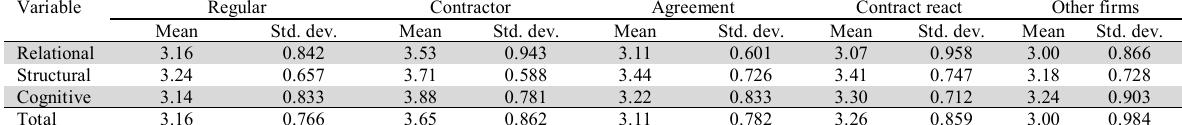
The summary of mean and standard deviation of social capital and employment status Variable Regular Contractor Agreement